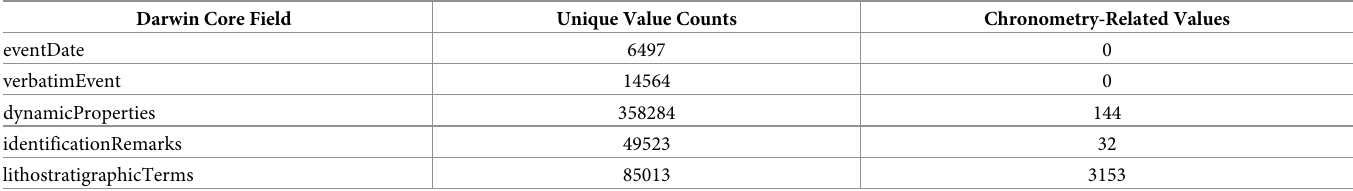
Table 2. Summary analysis of the records with basisOfRecord recorded as FossilSpecimens, with the number of unique values found in each targeted Darwin Core field and the number of chronometry-related values found within each field. Darwin Core